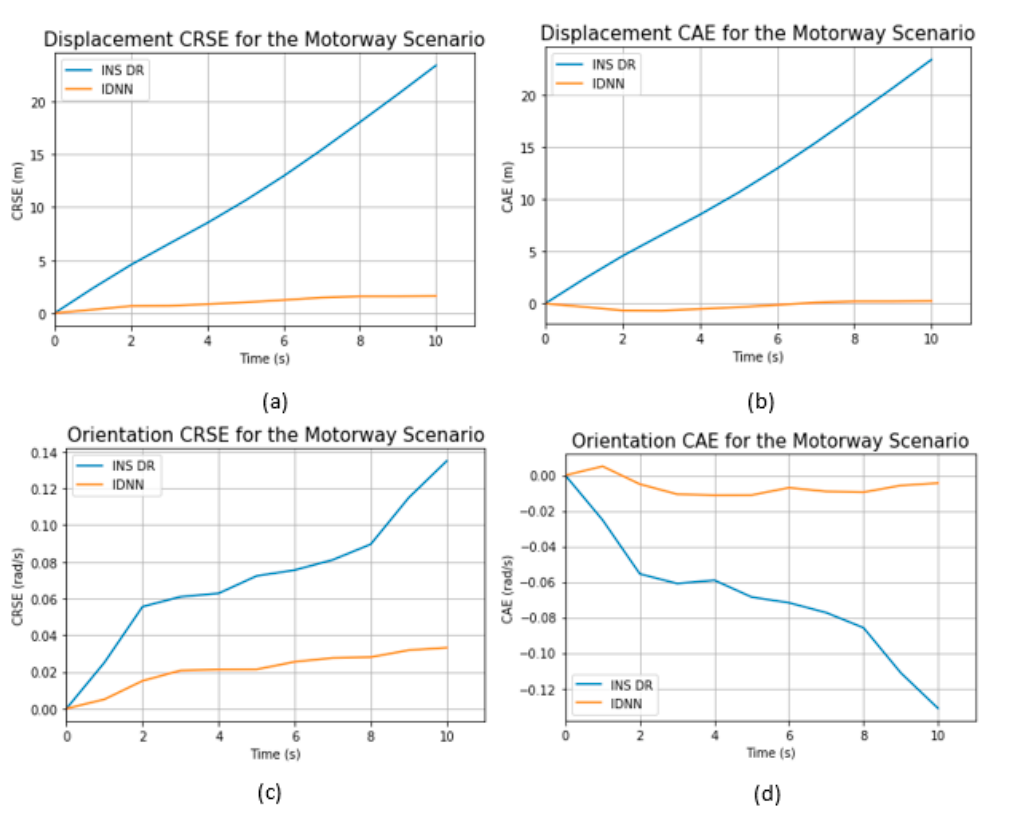
Figure 4. Showing the evolution of the estimation error over time in the motorway scenario based on the ( a ) Displacement CRSE, ( b ) Displacement cumulative absolute error (CAE), ( c ) Orientation rate CRSE and ( d ) Orientation rate CAE.